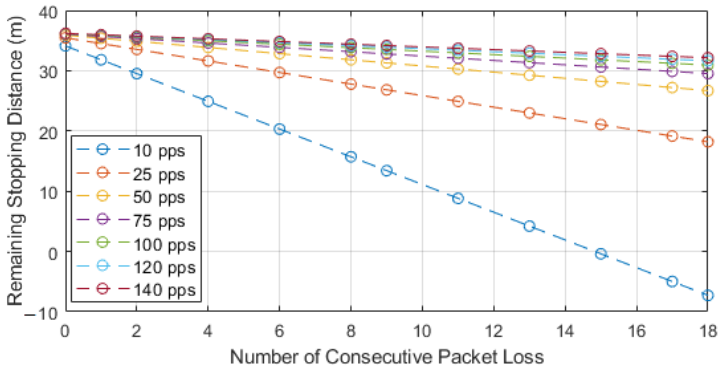
Figure 5. Fifty miles per hour (80.45 km/h) reduction in stopping distance.